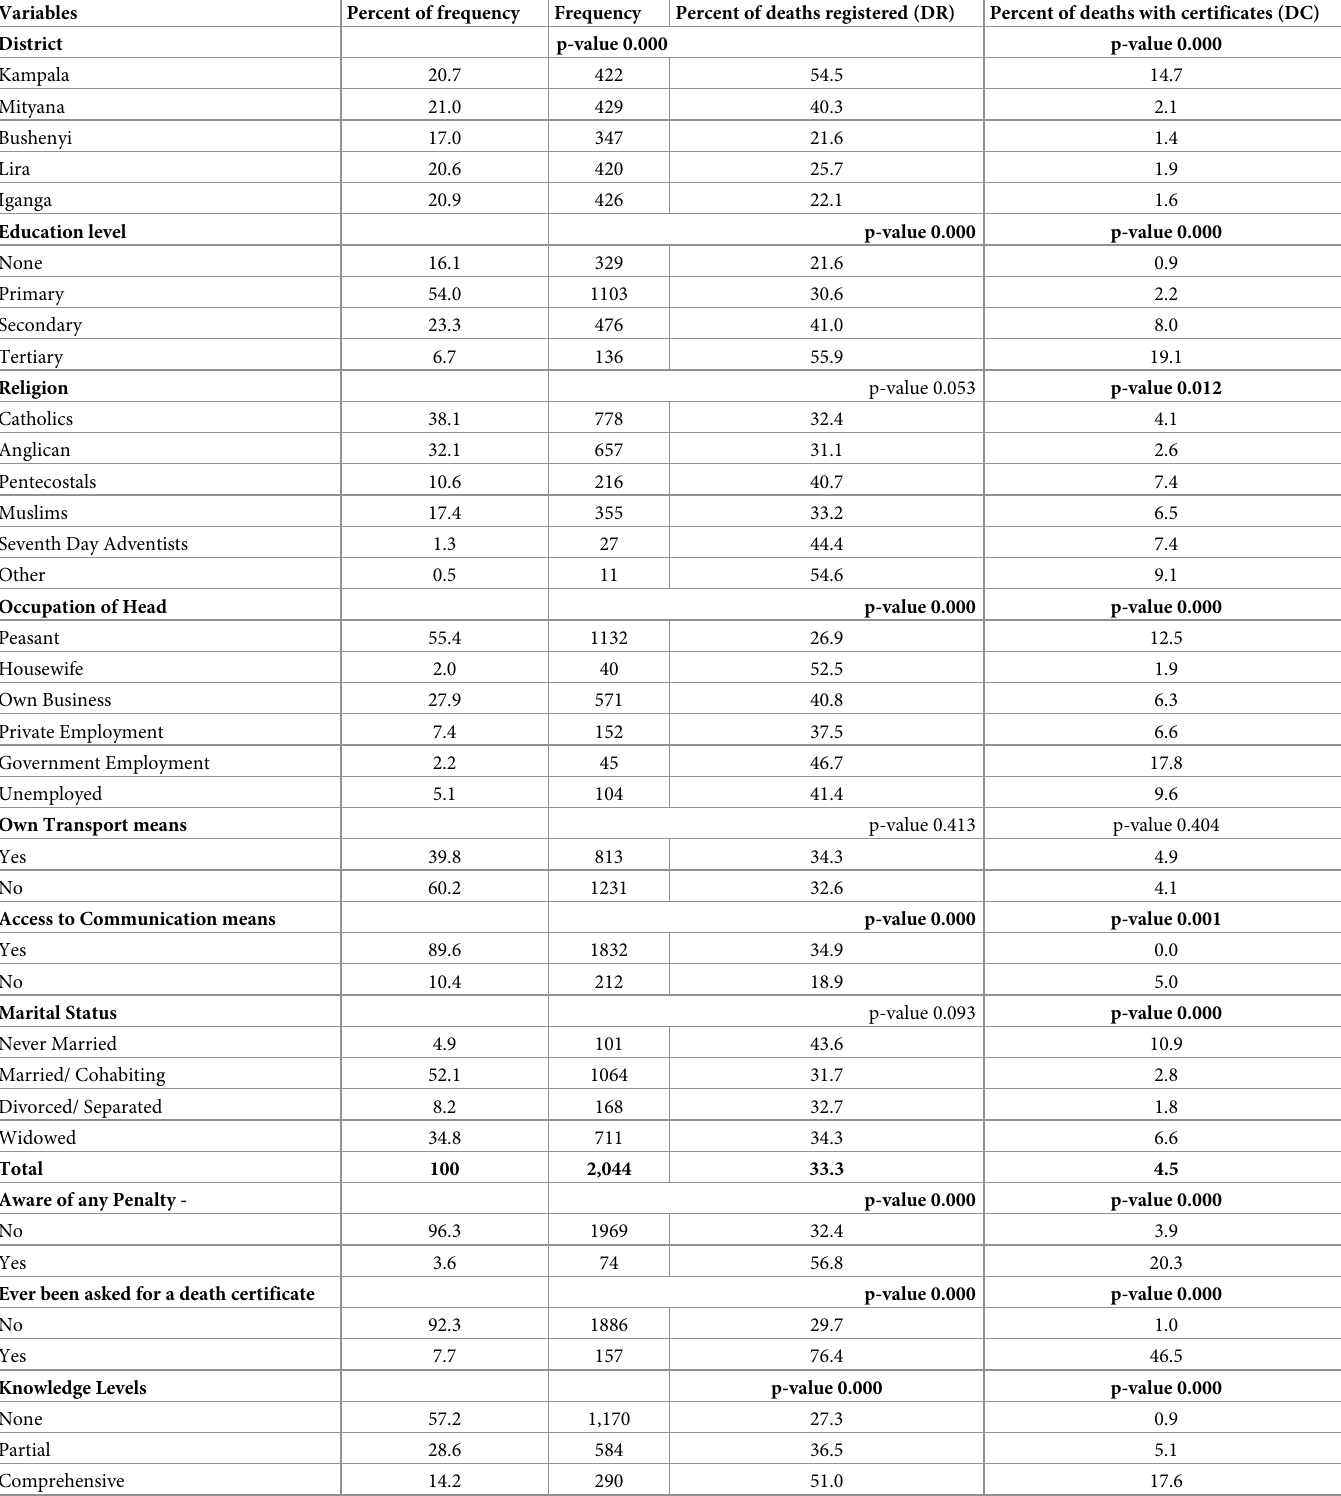
Table 2. Distribution of respondents and uptake of death registration and certification.